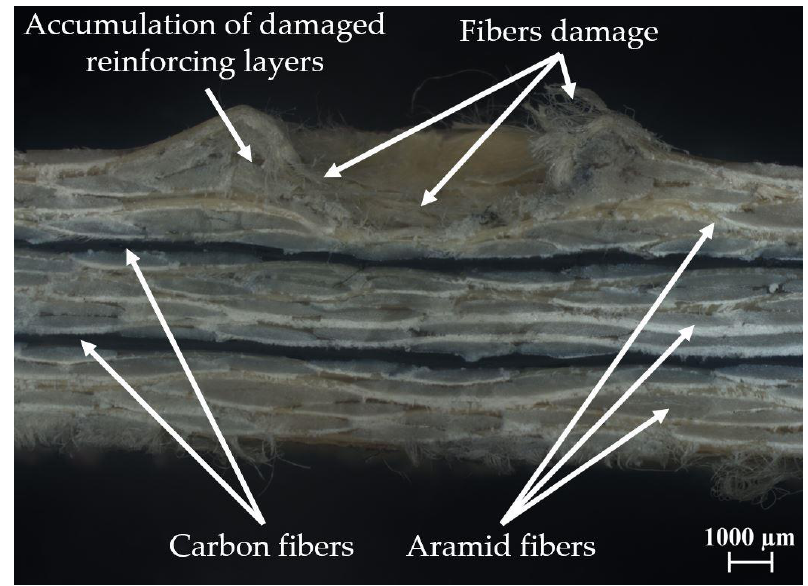
Figure 1. Microscopic image of damage formed in a multilayered composite with hybrid reinforcement after impact of the hemispherical striker.